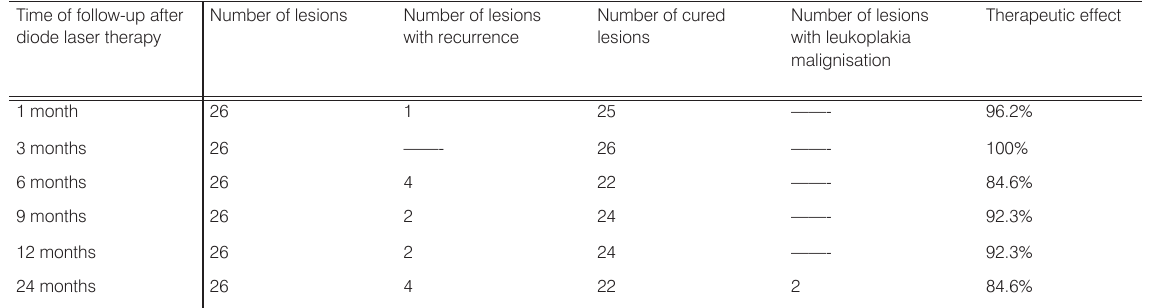
Table 9. Temporal development of the number of recurrences and malignisation in Group B Time of follow-up after diode laser